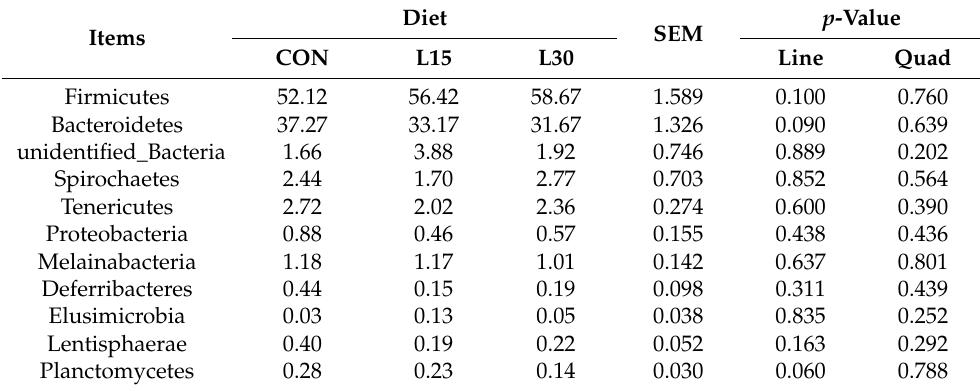
Table 2. Effects of different proportions of FHTR on the bacteria composition of Chuanzhong black goats at the phylum level (relative abundance ≥ 0.1%).